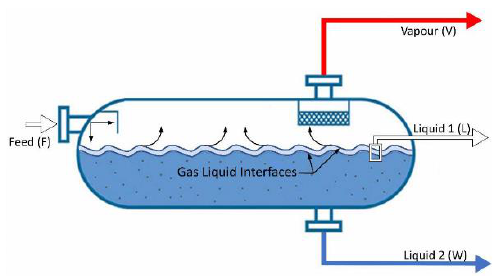
Figure 2. Schematic representation of a flash system dealing with three phases.